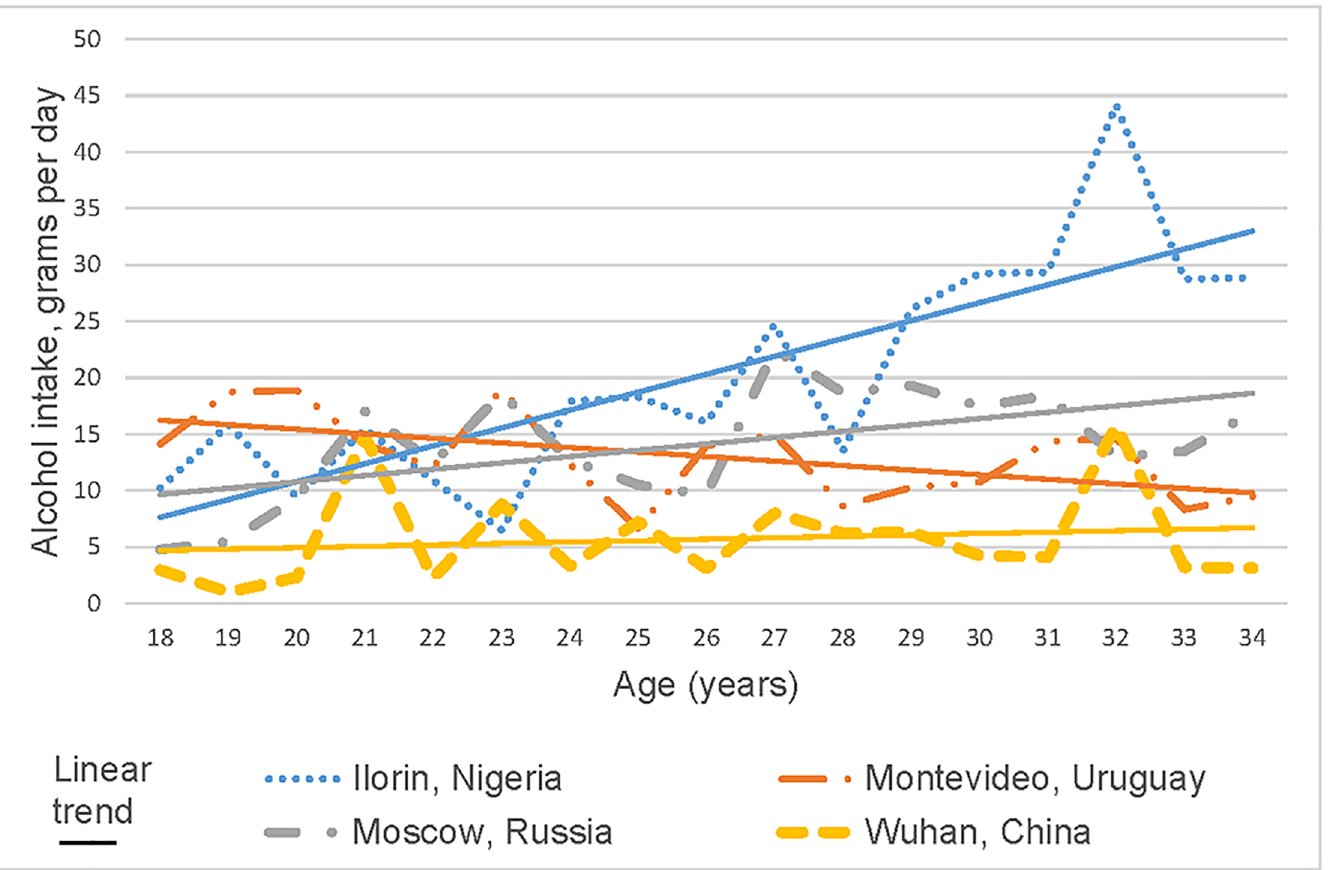
Fig 1. Averagealcohol intake, in grams per day, by